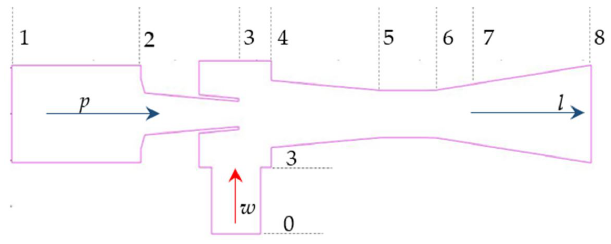
Figure 17. Locations in eductor for exergy (xE)